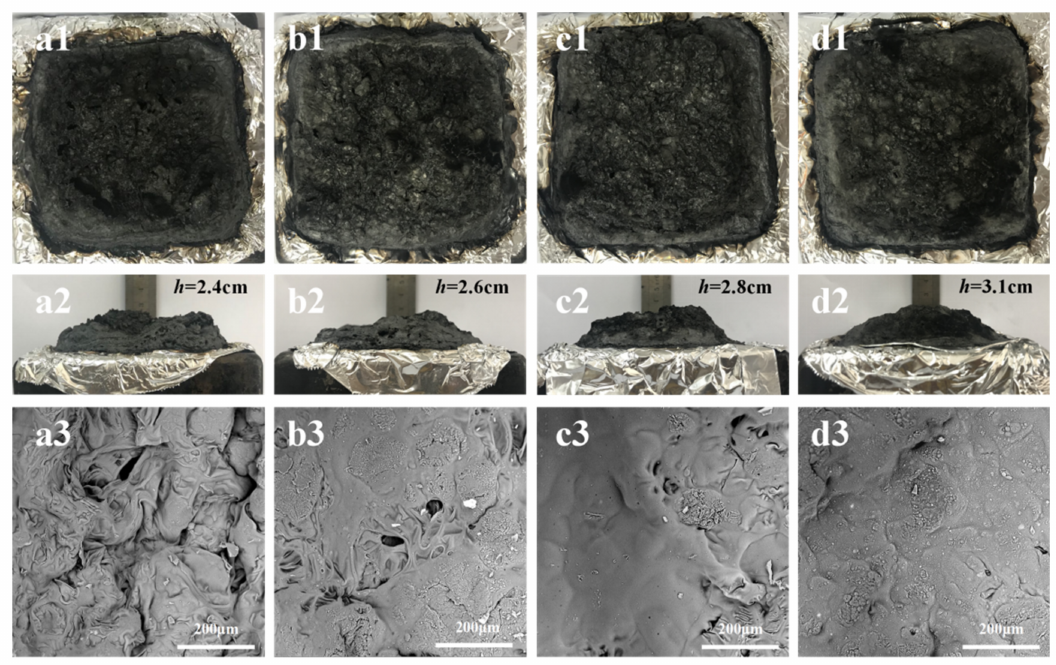
Figure 6. Residual char digital photos and SEM photos (400 × ) of the residual char after cone calorimeter test: ( a1 – a3 ) FRPLA; ( b1 – b3 ) 0.9DCP/FRPLA; ( c1 – c3 ) 0.3TAIC/FRPLA; ( d1 – d3 )